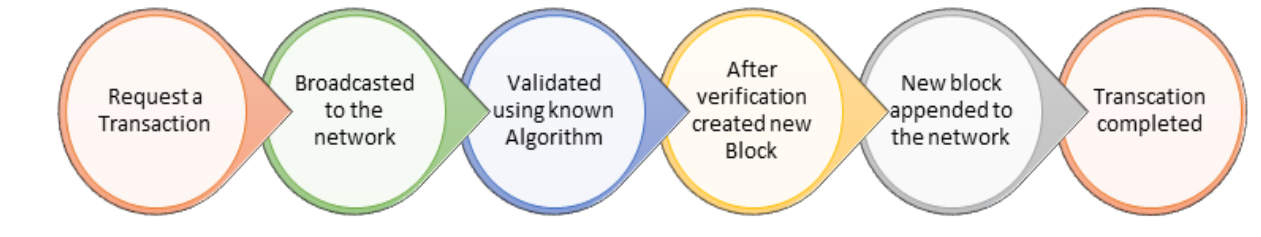
Figure 2. Working of a blockchain.